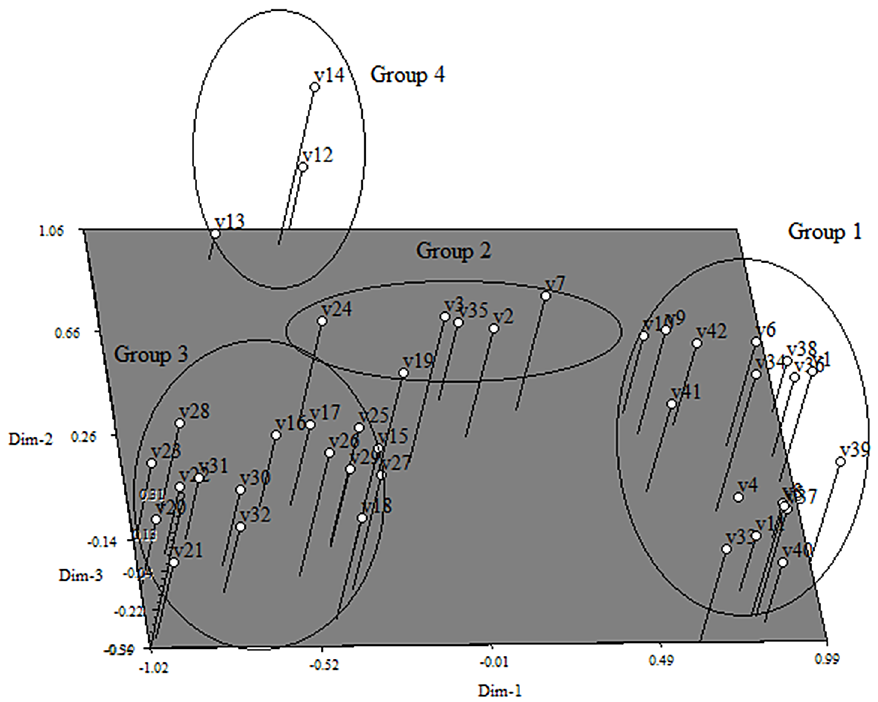
Table 6. Principle component analysis (PCA) explanation for 5 components of agro-morphological traits.